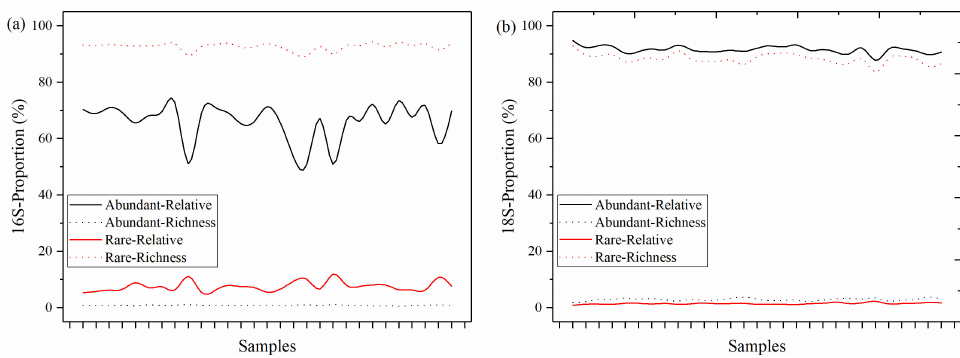
Figure 1. The proportion of OTU richness and relative abundance of the abundant and rare taxa, compared to the whole community in bacterial ( a ) and microeukaryotic ( b ) communities in each sample.